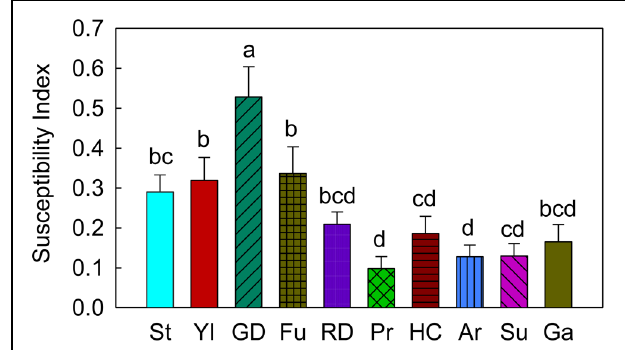
FIGURE 6 | Susceptibility index (SI) of different apple cultivars for oviposition of codling moth. St, Stayman; YI, York Imperial; GD, Golden Delicious; Fu, Fuji; RD, Delicious; Pr, Pristine; HC, Honeycrisp; Ar, Arlet; Su, Sunrise; Ga, Gala. Each bar represents standard error of mean. N = 72 for all the cultivars, except GD, YI, and HC, where N = 95 and Pr and Ga, where N = 54. Error bar (standard error of mean) represents variability of oviposition in different cultivars across seasons (early and late), choices (no-choice and multiple-choice) and years (2006–2008). Different letters over bars indicate significant difference ( P <